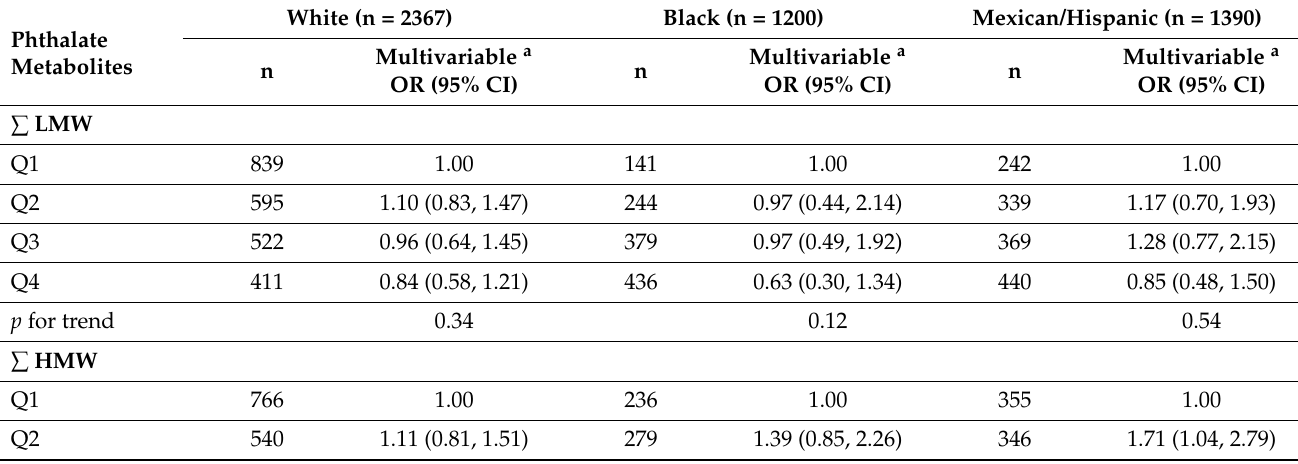
Table 7. Associations between urinary phthalate metabolite summary measures and metabolic syndrome among women by race, NHANES